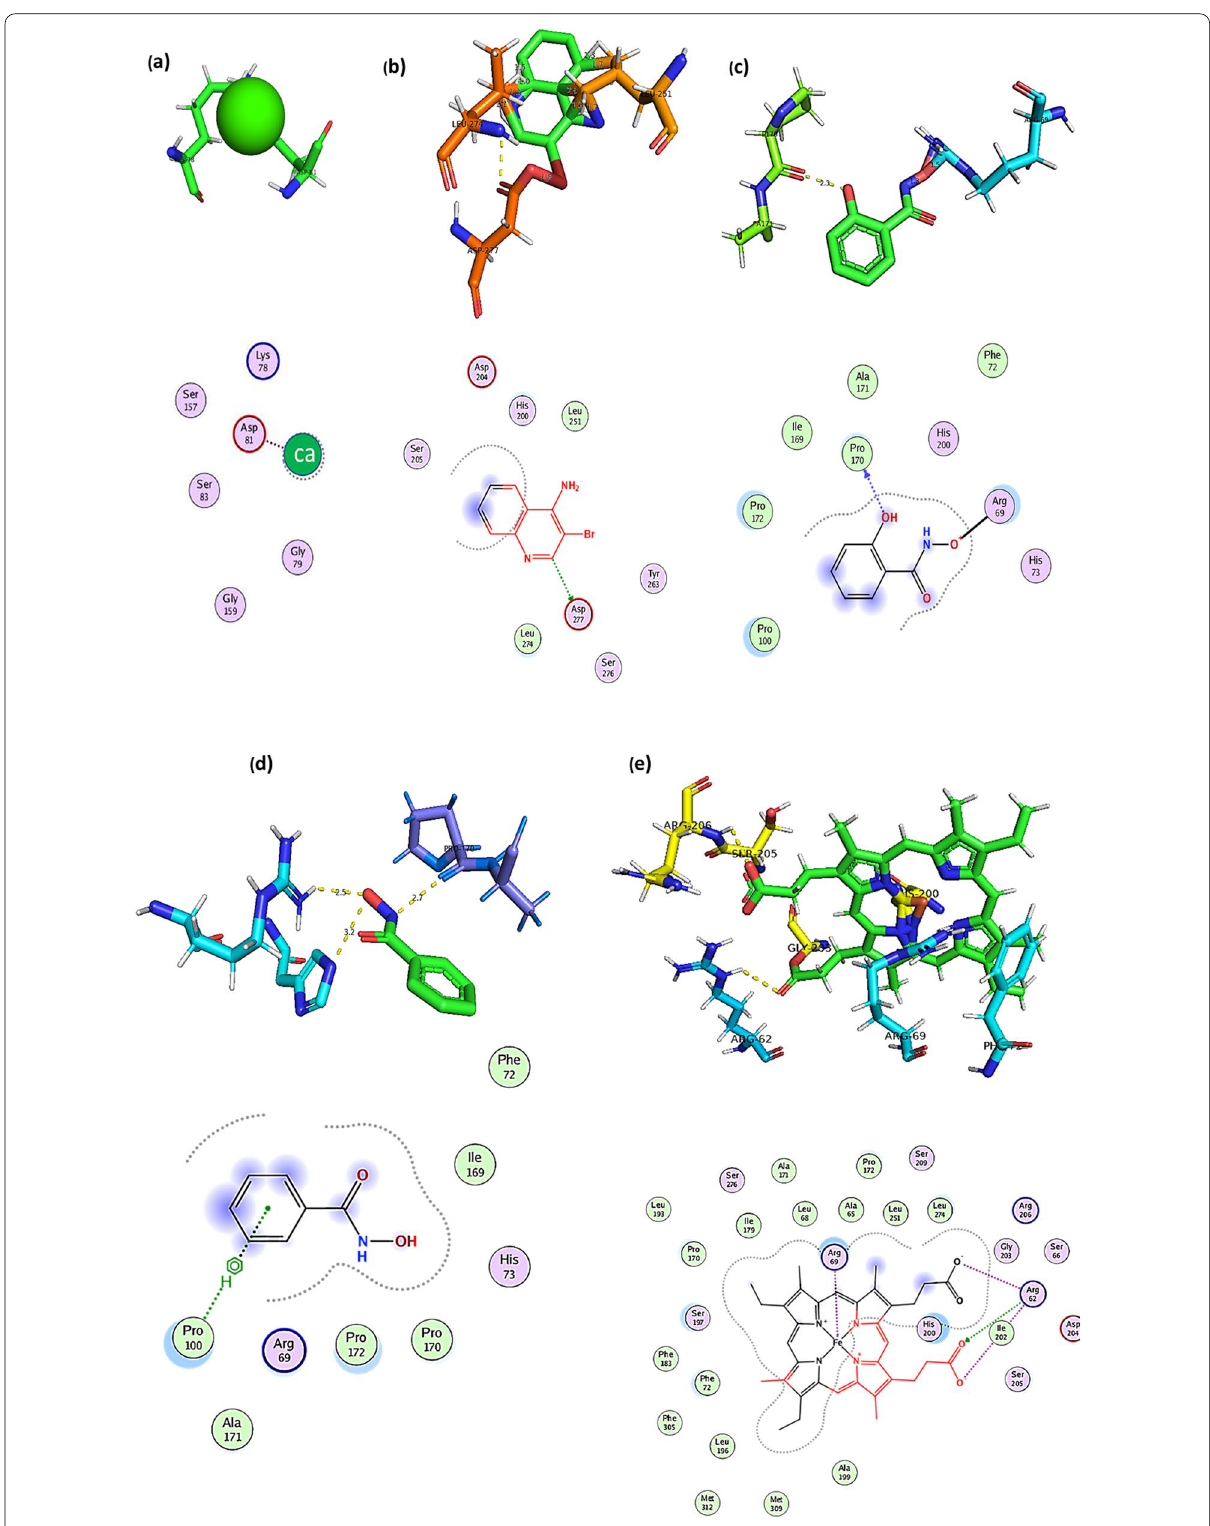
Fig. 5 Predicted binding sites in complex with